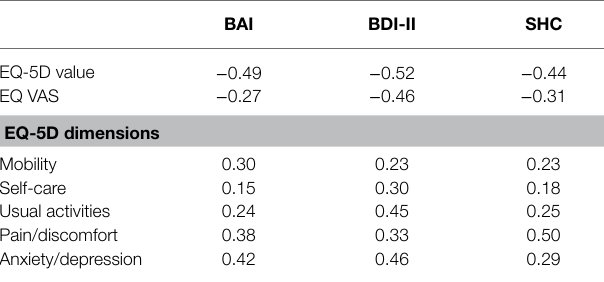
TABLE 6 | Pearson’s correlation coefficient between the EQ-5D and clinical measures ( N = 890). BAI BDI-II SHC EQ-5D value − 0.49